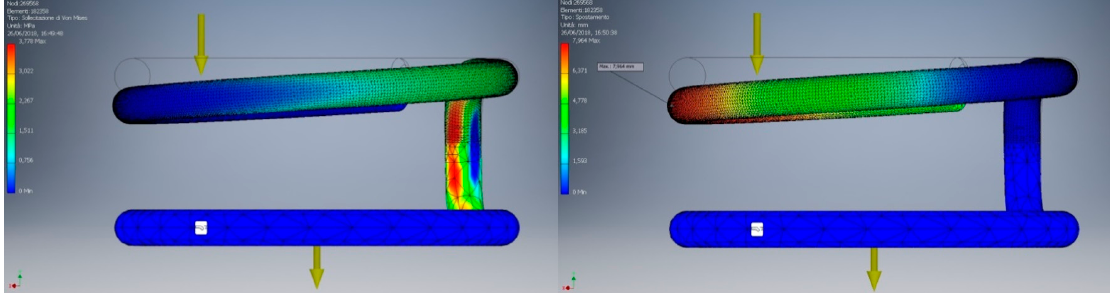
Figure 12. Von Mises stress and displacement analysis of the support.